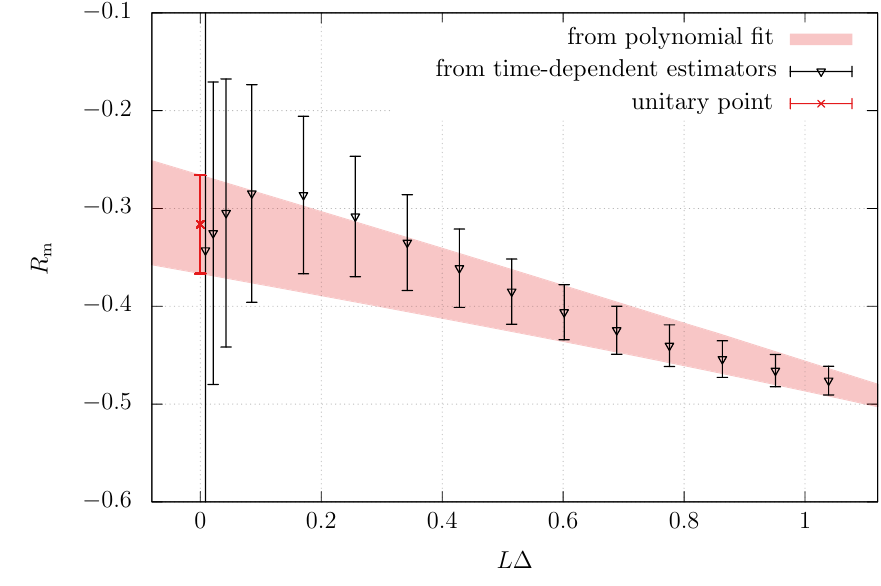
Fig. 10 R m plotted against L (cid:6) for ensemble B1k4. Points are obtained by measuring current quark masses directly and using (2.11c), as detailed in this appendix. The continuous band results from the combined fits described in Sect. 4.2. The red point gives the result at